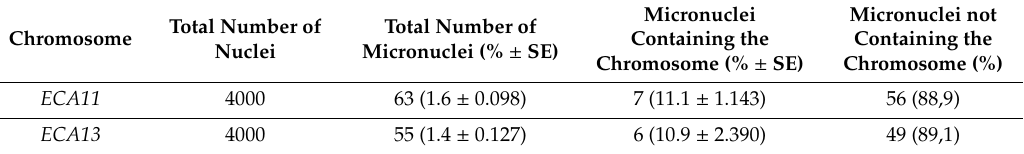
Table 3. Spontaneously occurring micronuclei under control conditions without cytokinesis-block.